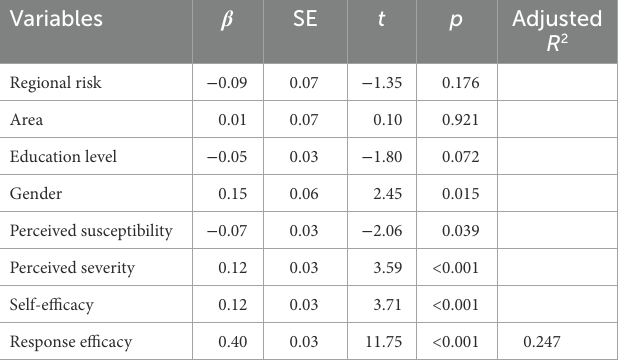
TABLE 5 Results of multivariate linear analysis for perceived susceptibility, perceived severity, self-efficacy and response efficacy on preventative health